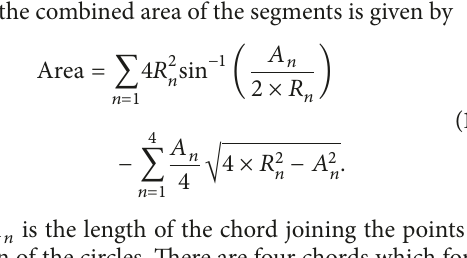
for a given circular